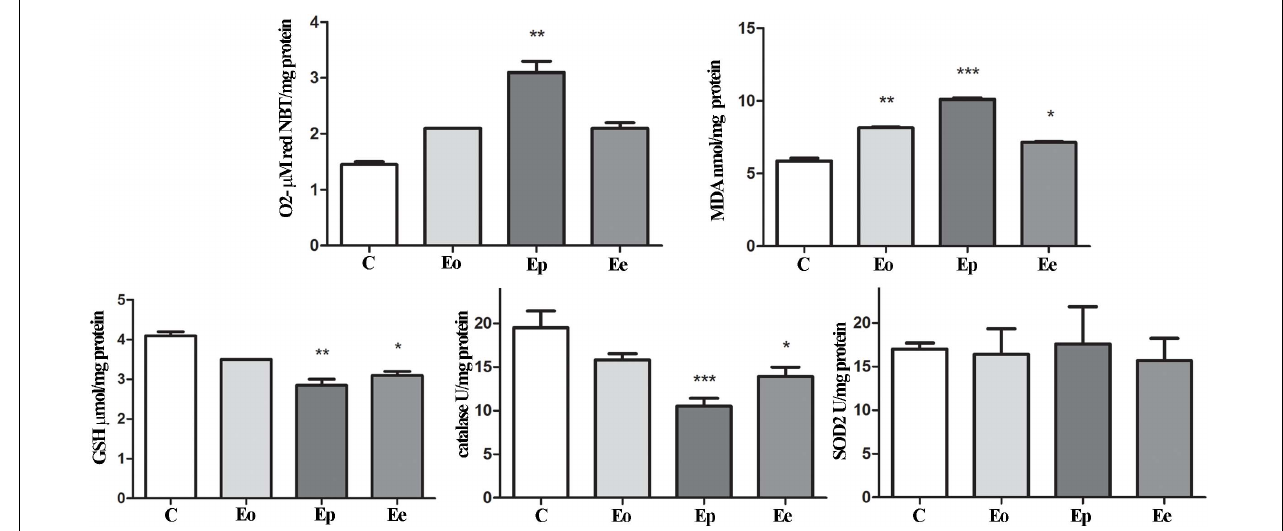
FIGURE 6 | Oxidative and lipid peroxidation status assessment in the adrenal glands of rats during EAE. To assess the oxidative status, O 2 − ( µ mol/min/mg protein), GSH ( µ mol/mg protein), and MDA (nmol/mg protein) levels were determined and catalase (U/mg protein) and SOD2 (U/mg protein) activities were assayed in the adrenal gland at the onset (Eo), peak (Ep), and end (Ee) of EAE. Values are presented as means ± SEM. * p < 0.05, ** p < 0.01, and *** p < 0.001 statistically significant difference compared with the control (C)